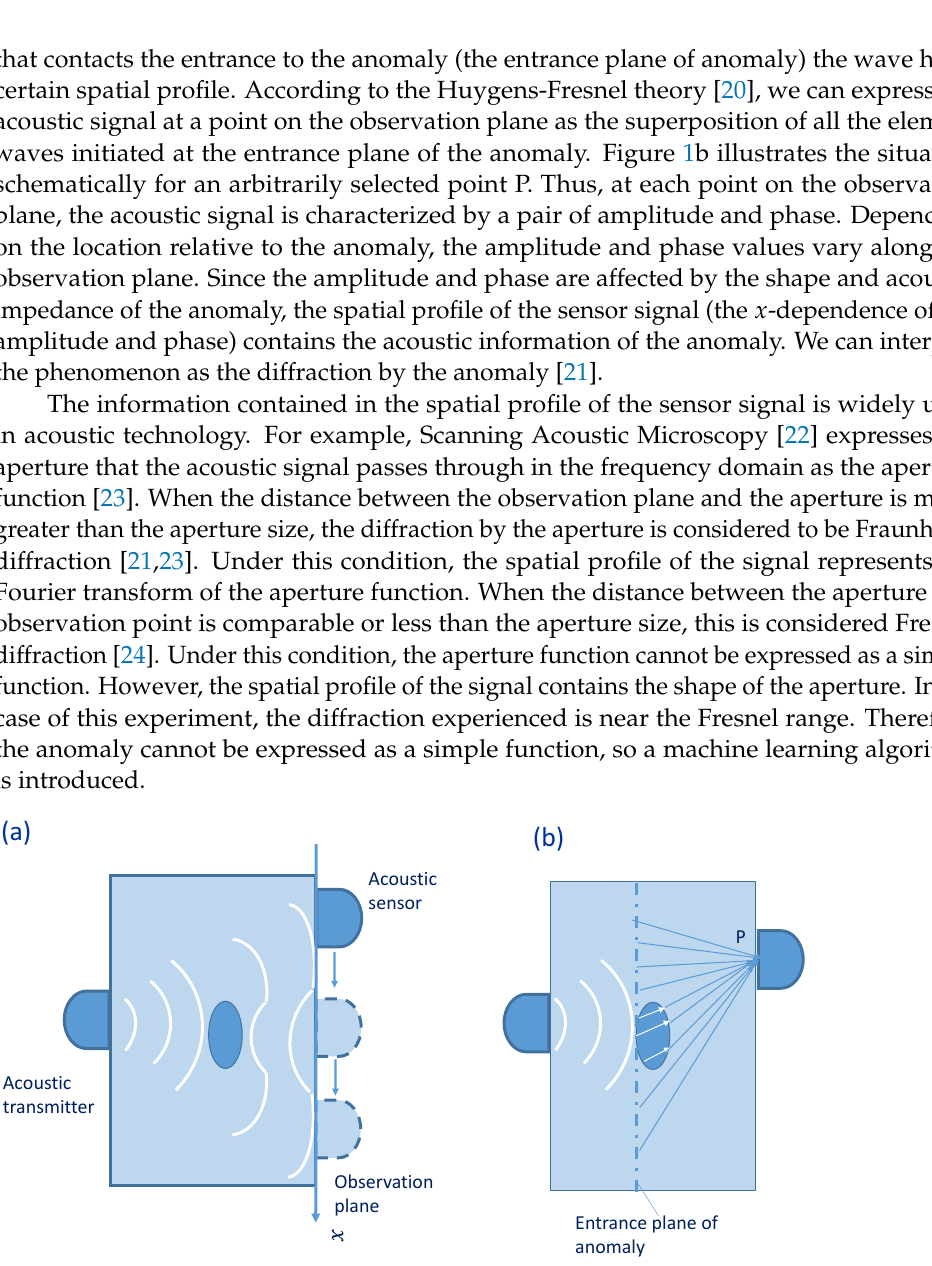
Figure 1. Acoustic wave traveling through anomaly in bulk material. ( a ) wave incident to anomaly and wave diffracted by anomaly; ( b ) signal captured by sensor represented by element waves according to Huygens’